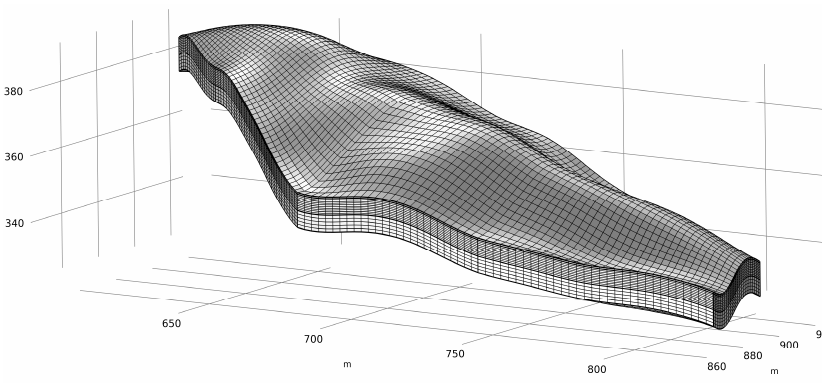
Figure 7. Unit Figure 7. Unit division.